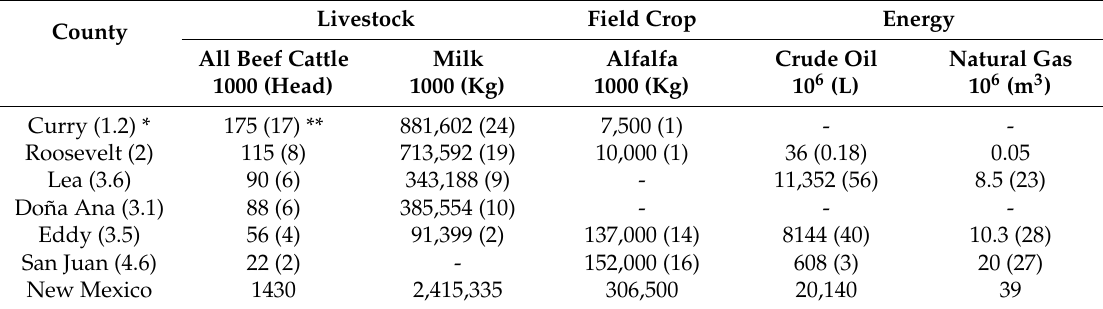
Figure 2. A depiction of the cloud-based accuracy assessment and area estimation workflow: System for Earth Observation Data Access, Processing, and Analysis for Land Monitoring (SEPAL) [41] was used in each step of data preparation, sampling design, response design, and analysis. In step 1 (Data Precreation), the NLCD for each year for the study counties were archived in SEPAL. In step 2 (Sampling Design), the Stratified Area Estimator tool available in SEPAL was used to calculate area, generate legends, determines expected users and producer’s accuracy, sampling size and preparation of response design. In step 3 (Response design and Reference data collection), the Collect Earth (CE) tool which integrates Google Earth and Google Earth Engine (GEE) was used for visual interpretation and labeling of spatial assessment units and database archiving. In step 4 (Analysis), the Stratified Area Estimator tool of SEPAL was used to estimate the overall, user’s, and producer’s accuracies as well as area estimates along with their confidence interval (CI). Table 1. Livestock, field crop, and energy production in New Mexico